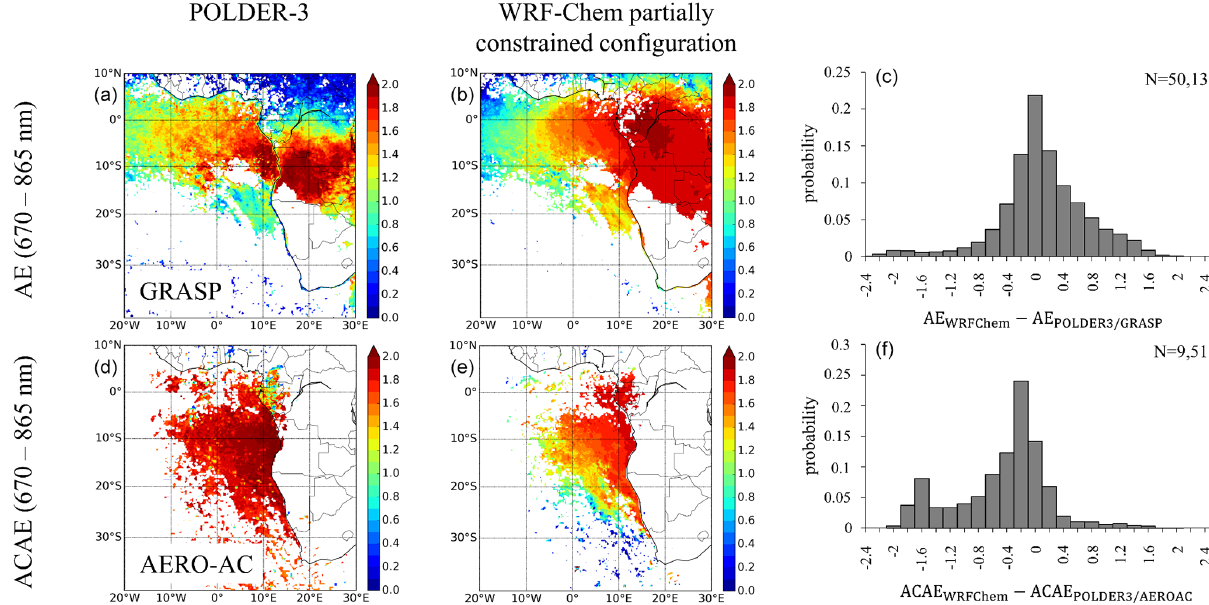
Figure 11. Monthly averaged Ångström exponent retrieved by POLDER-3 in clear sky with GRASP (AE 670 − 865 , a ) and above clouds with AERO-AC (ACAE 670 − 865 , d ) and simulated with the WRF-Chem partially constrained configuration (b, e) for July 2008, with the associated histograms of differences between the model and the satellite observations over the whole domain (c, f) .